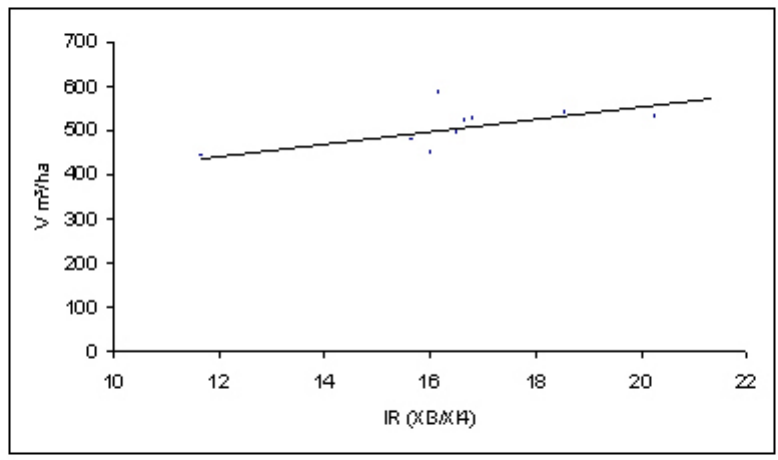
FIGURE 8 . Correlation between stand volume values and index IR in degraded Lenga.